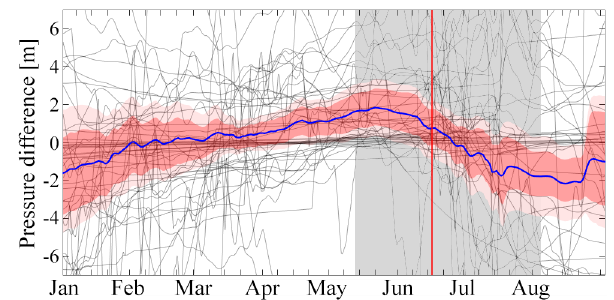
Figure 8. Mean water pressure computed over a 1-day running win- dow for each of the 55 sensors that did not display diurnal oscilla- tions during 2016, shown in black. For legibility, we have subtracted the mean over all sensors and the time window shown. The blue line shows the mean over all the black lines at a given time (i.e. over all the sensors) and the bootstrap confidence intervals (Efron and Tib- shirani, 1993) of 90 and 99% (dark and light pink shading, respec- tively). Gray shading represents the period over which the initiation of diurnal oscillations was observed in connected boreholes, and the red vertical line is the median time at which diurnal oscillations first appeared in the 70 boreholes that did experience such oscillations during